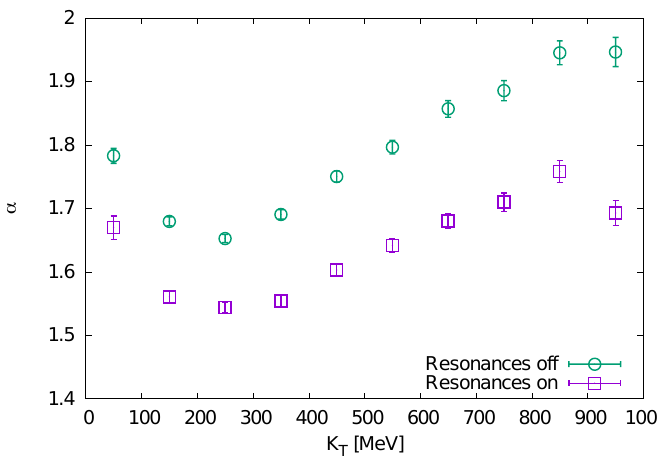
Figure 5. The Lévy parameter of the 3D fits to the correlation function according to Equation (20). Compared are simulations with and without resonances. Vertical error bars show the 1 σ intervals, resulting from fitting the correlation function with the ansatz of Equation